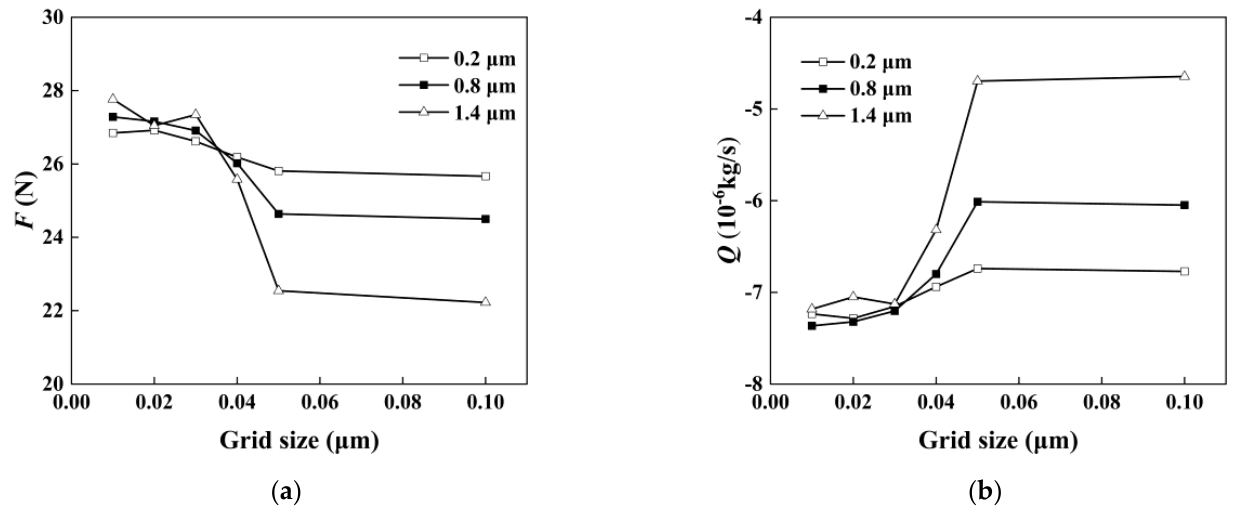
Figure 4. Effect of the number of circumferential and radial divisions ( N ) on the sealing performance: ( a ) Effect on opening force, ( b ) effect on leakage rate. Considering the number of grids, this study tested the independence of the grid divisions in the grooved zone, non-grooved zone, and stationary ring surface. Figure 5a,b shows the calculation results of the opening force and the changes in the leakage with the size of grids when σ 1 was 0.2, 0.8, and 1.4 µ m. As Figure 5a,b shows, when the grid size of the grooved zone was 0.03 mm, the effect of the grid size on the opening force and leakage of the lubrication film was negligible. Considering the calculations for accuracy and time, when the rotating ring’s grooved zone was rough, the grid size of the selected surface was 0.03 mm.